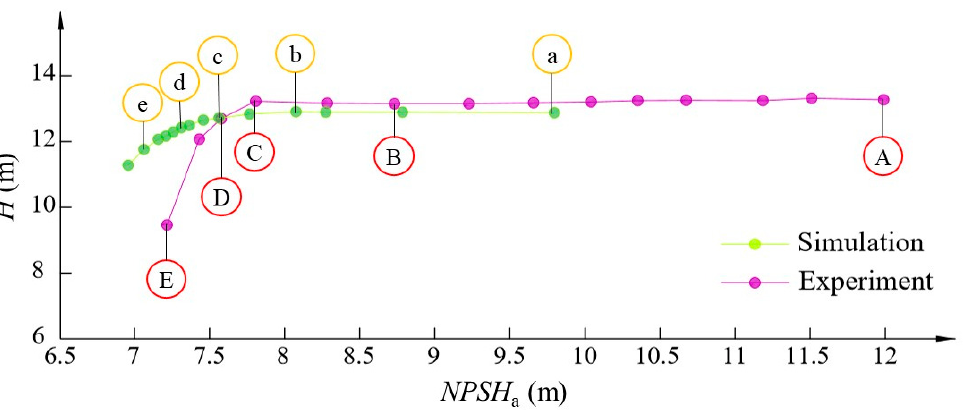
Figure 7. Cavitation flow structure numerical calculation and experimental comparison conditions [28].